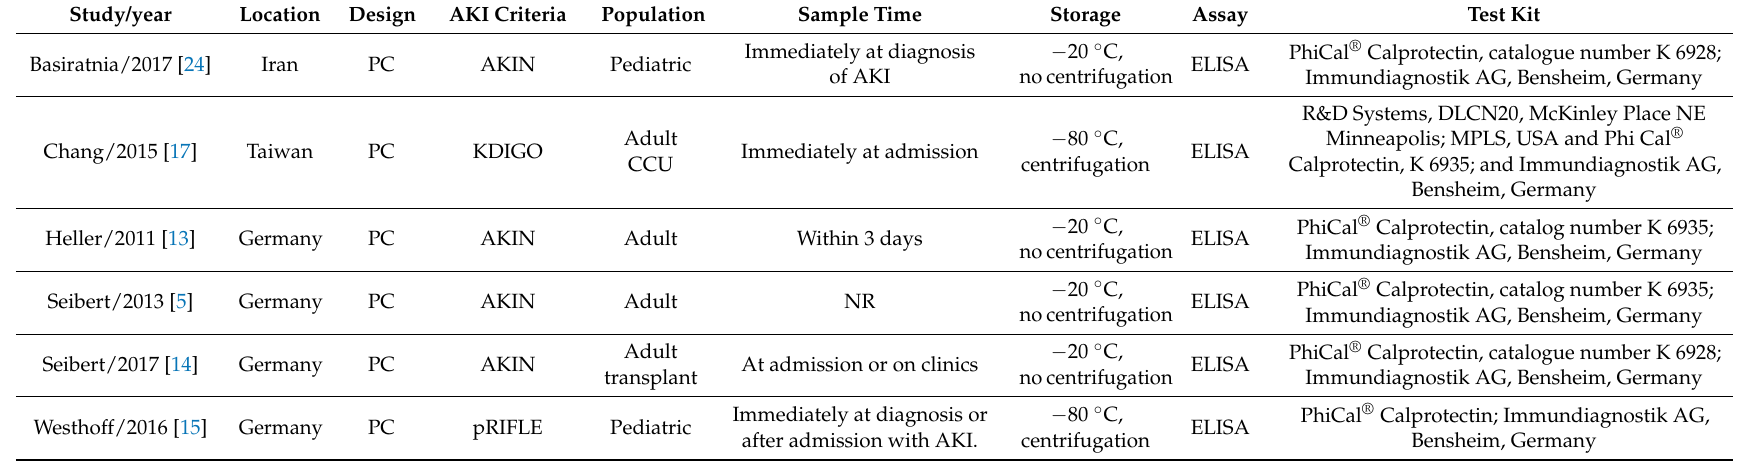
Table 1. The characteristics of the six included